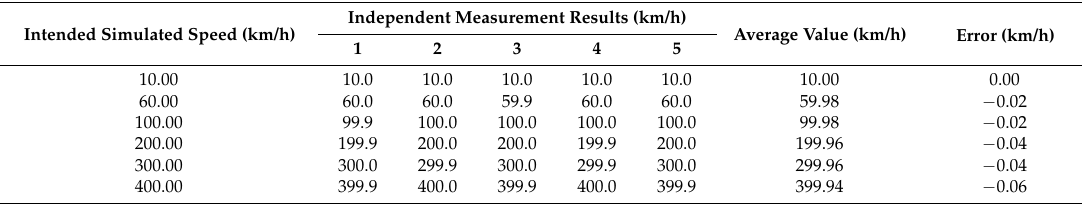
Table 4. Numerical results of the simulated speed